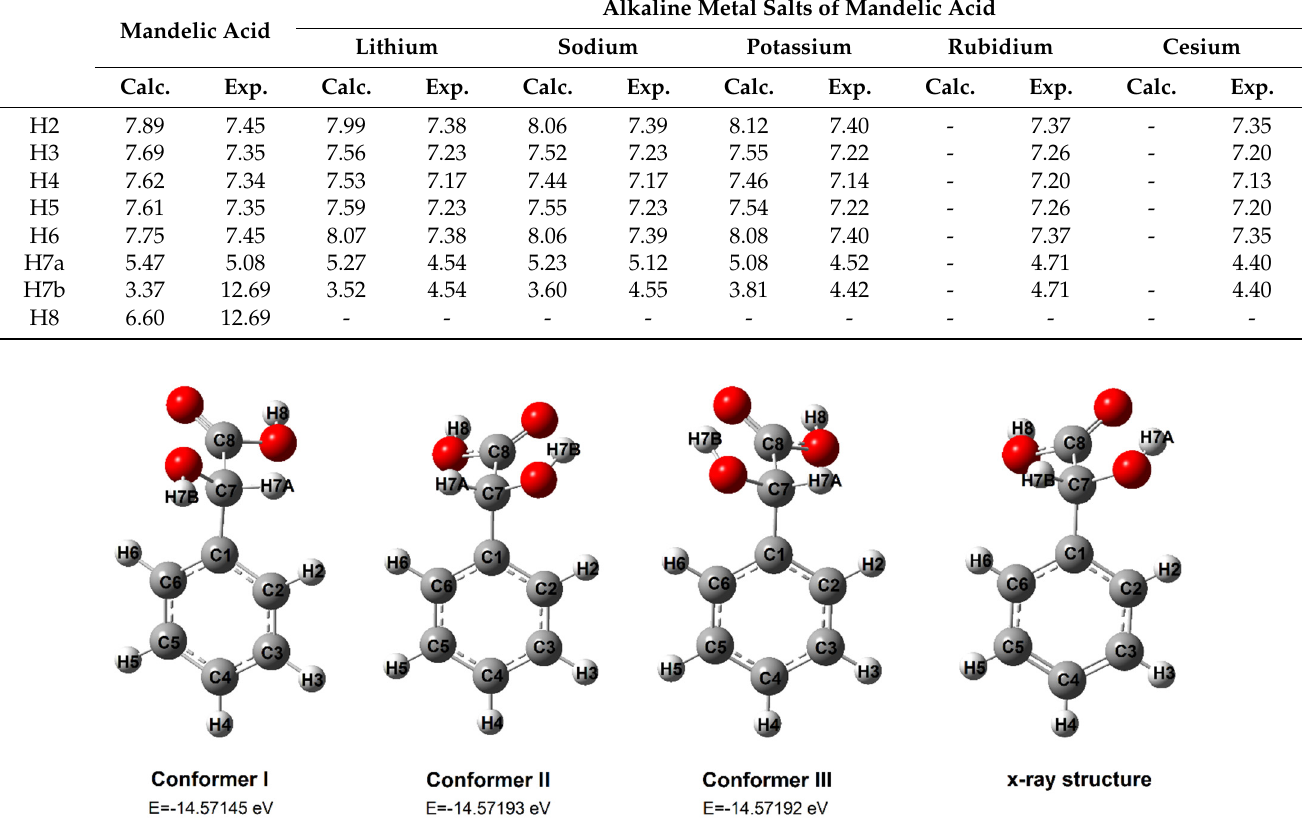
Table 2. 1 H chemical shift for mandelic acid and its alkali metal salts (in experimental 1 HNMR spectra and theoretically calculated in B3LYP/6-311++G(d,p)). Alkaline Metal Salts of Mandelic Acid Mandelic Acid